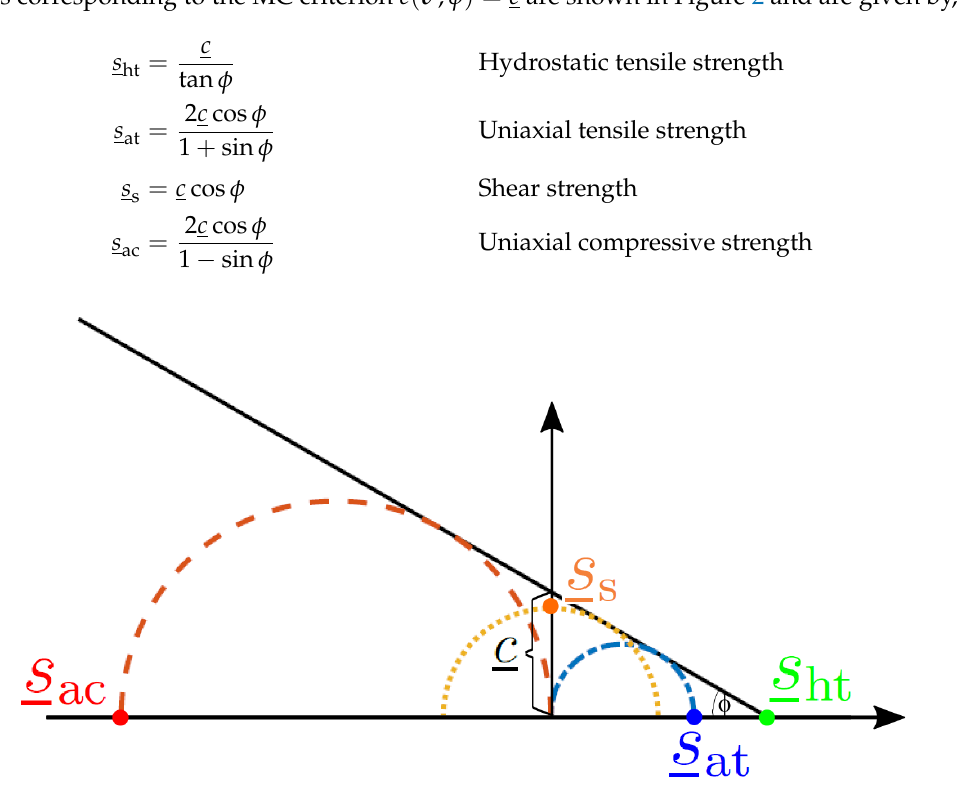
Figure 2. Relation of different fracture strengths, s ht , s at , s s , and s ac to cohesion c